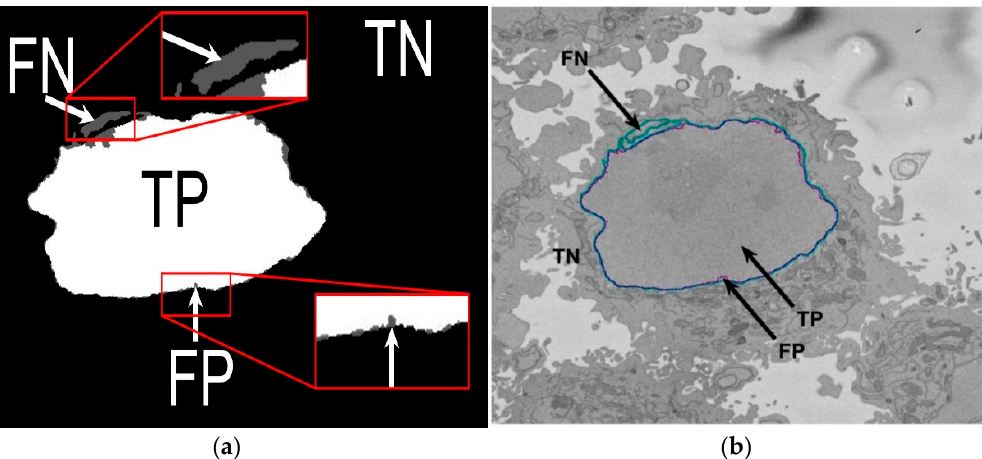
Figure 5. Illustration of the pixel-based metrics. ( a ) True Positives (TP, nuclear pixels segmented as nucleus), true negatives (TN, background pixels segmented as background), false positives (FP, background pixels segmented as nucleus), and false negatives (FN, nuclear pixels segmented as background). ( b ) Segmentation overlaid on one image: Ground truth (GT) in cyan, automated segmentation in purple.